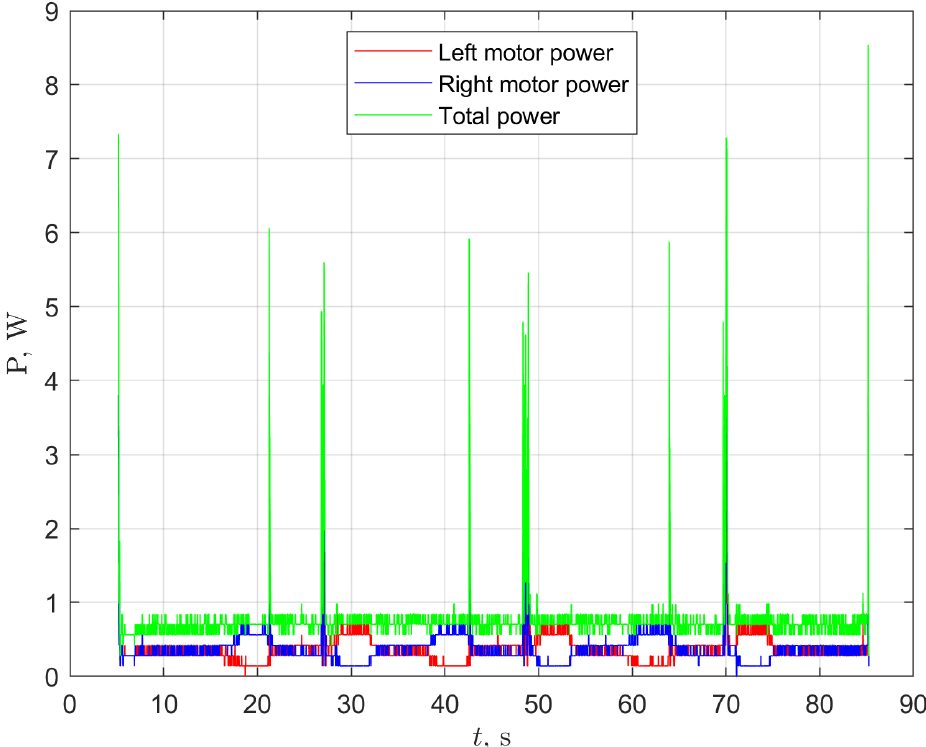
Figure 10. Individual motor power and the total power over time, for the lowest value of the cost function equal to 1—track